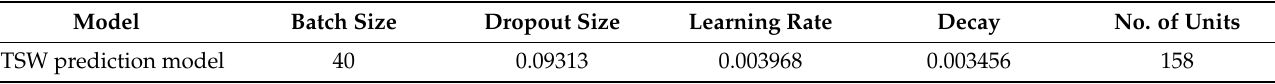
Table 3. Hyperparameters selected by the Bayesian optimization